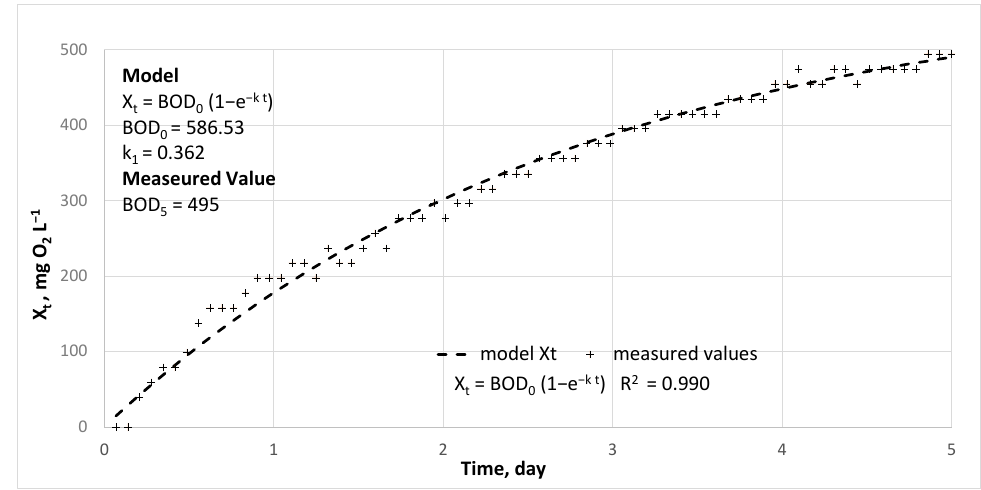
Figure 8. Value of biochemical oxygen consumption in rejected water, WWTP 3, sample 1.